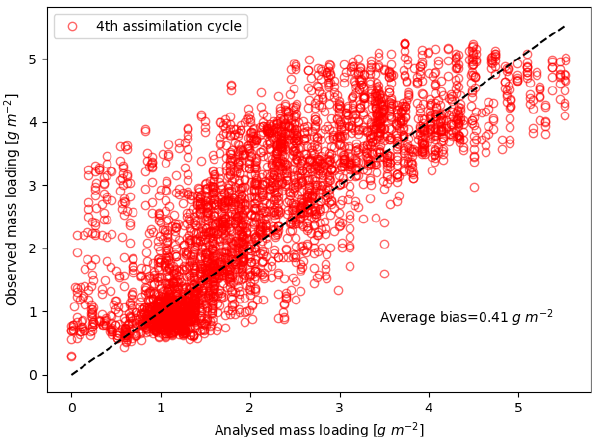
Figure 9. Comparison of SO 2 mass loading observations and the analysis state at the fourth assimilation cycle. In general, analy- sis underestimates observations. In this case, an average bias of 0 . 41g m − 2 was